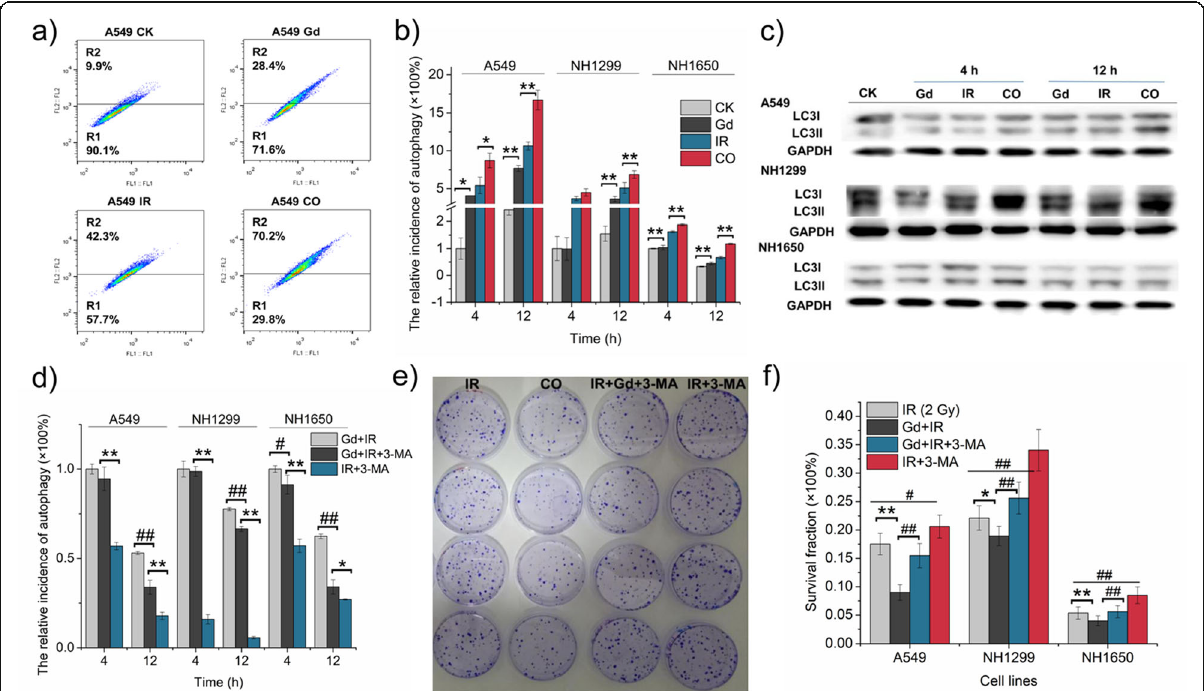
Fig. 6 Autophagy-induced death was promoted by GONs in NSCLC cells exposed to carbon ion irradiation. a Images of autophagic rates in A549 cells at 12 h post-radiation as measured by flow cytometry (Sysmex CyFlow Cube 6, German). b The relative incidence of autophagy in the three studied cell lines. c Western blot results of LC3II expression in the three studied cell lines. d The relative incidence of GONs-induced autophagy in the presence or absence of 3-MA. e The surviving A549 cells were dyed with crystal violet in the clonogenic survival assay. f Surviving fraction of NSCLC cells after treatment with 2 Gy carbon ion radiation and/ or GONs with or without 3-MA. * p < 0.05 or ** p < 0.01 represent statistically significant or extremely significant differences, respectively, induced by GONs. Similarly, # p < 0.05 or ## p < 0.01 indicated the differences owing